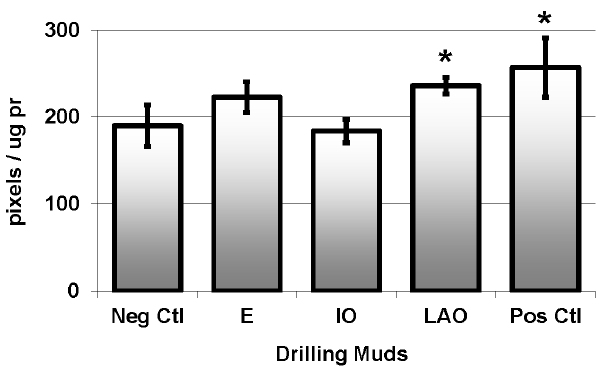
Figure 4. Stress proteins HSP-70 (pixels/mg pr, mean 6 SEM) measured in pink snapper exposed to E: ester; IO: isomerised olefin; and LAO: linear alpha olefin SBMs. * indicates statistically different from negative control